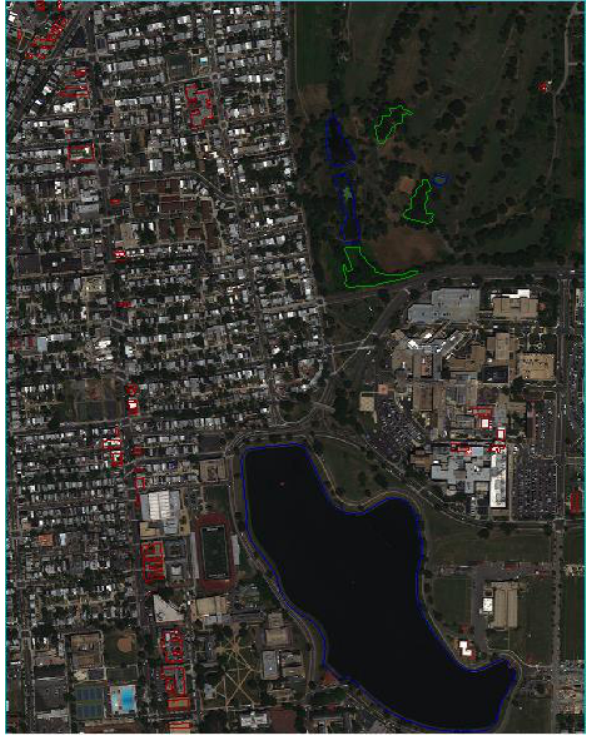
Figure 4. Samples for supervised classification loaded with VHR image